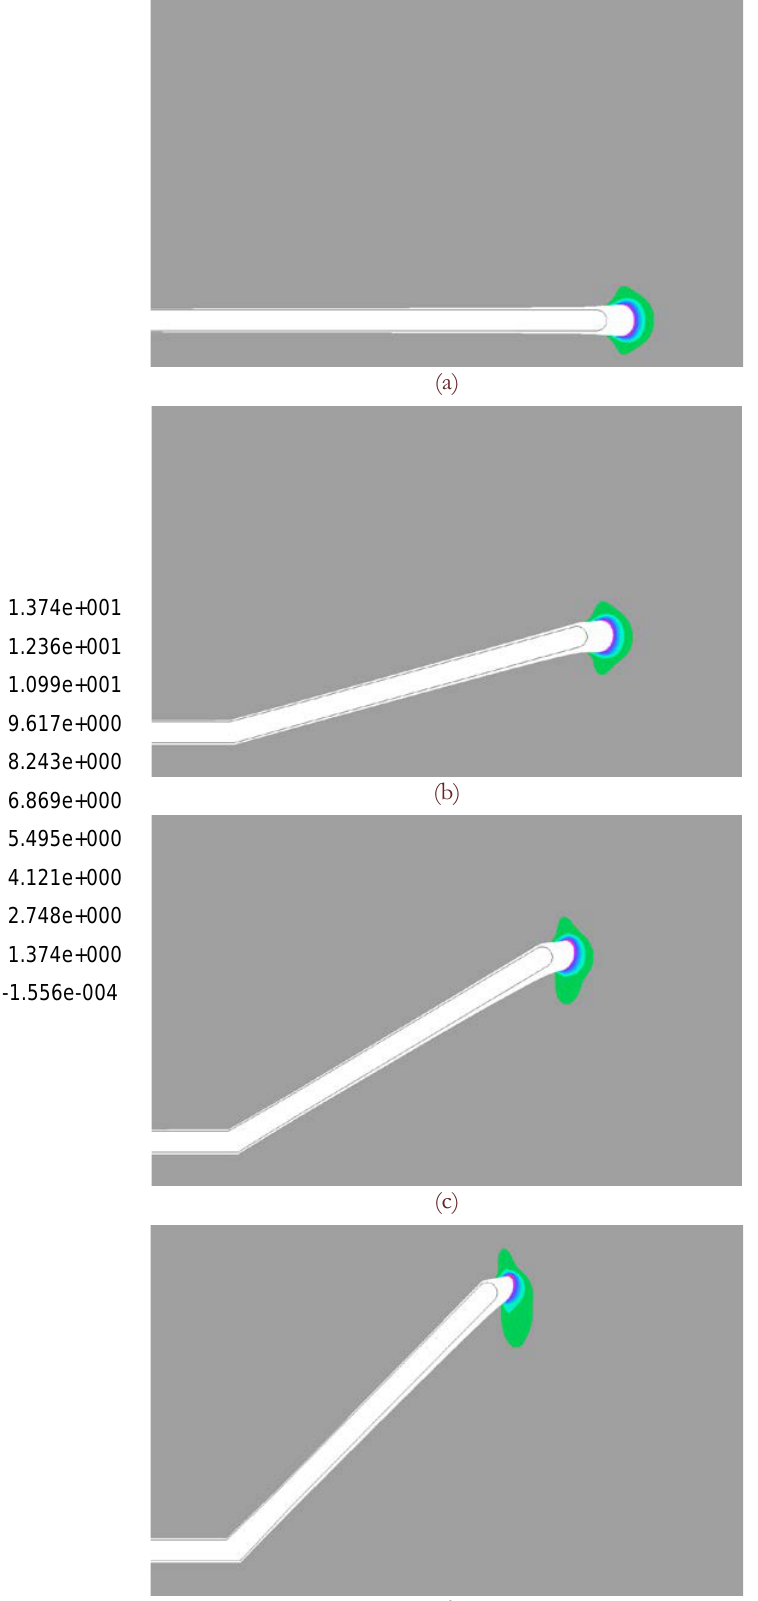
Figure 3: Cumulative equivalent plastic strain for Δ K =25MPam 1/2 : (a) α 0 =0º; (b) α 0 =15º; (c) α 0 =30º; (d) α 0